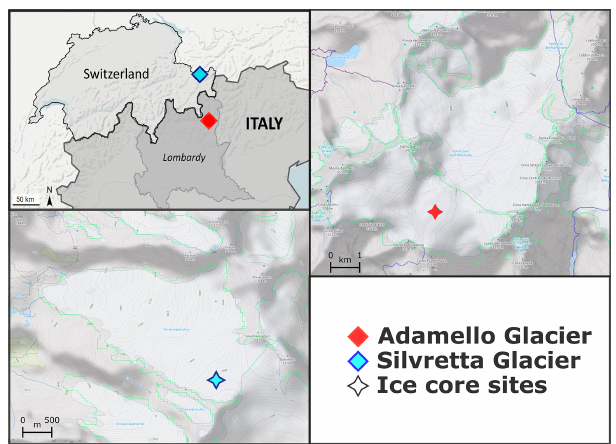
Figure 1. Map showing the locations of the Adamello (red dia- mond) and Silvretta (light-blue diamond) glaciers and respective zoom-in maps on ice core drilling sites: Adamello (red star) and Silvretta (blue star). All maps are north–up